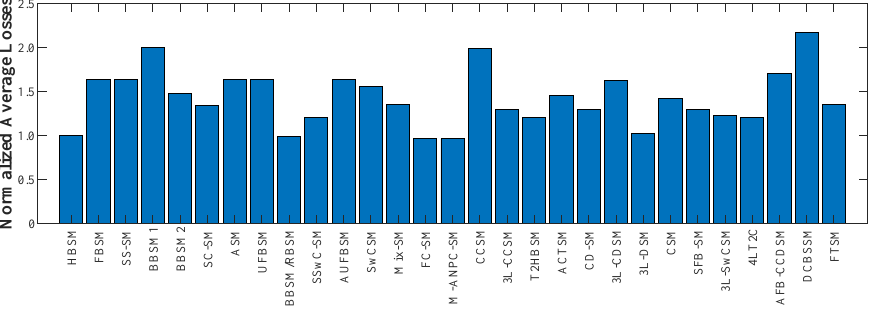
Figure 19. Average loss of SMs at unity power factor.